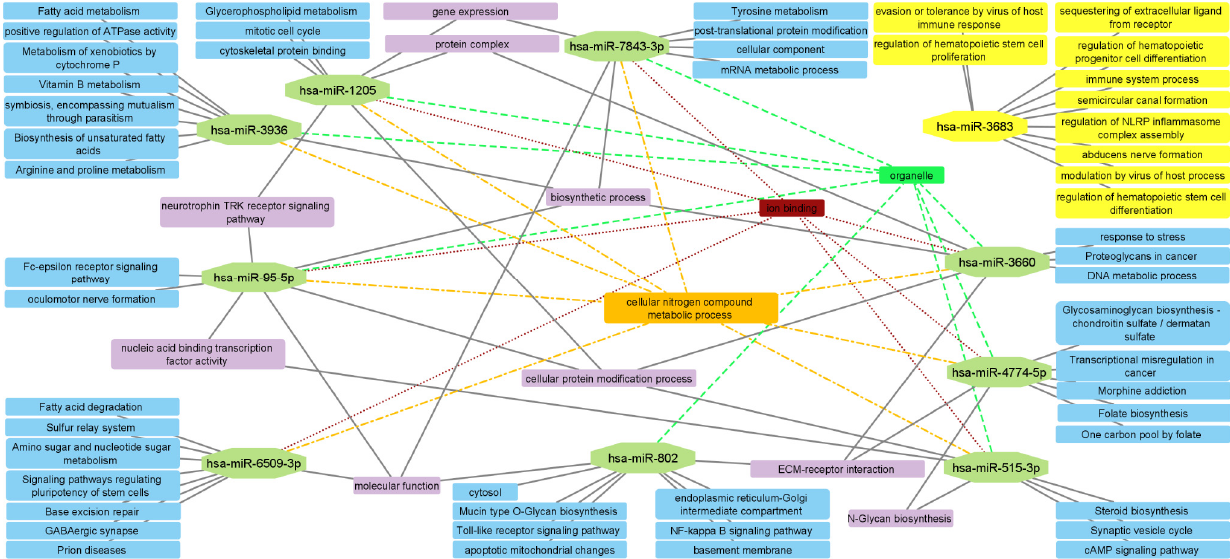
Figure 3. Functional network performed using selected downregulated miRNAs in PEXG. The network is made up of the 10 most statistically significant for each miRNA. Analysis made using DIANA-miRPath v3.0.